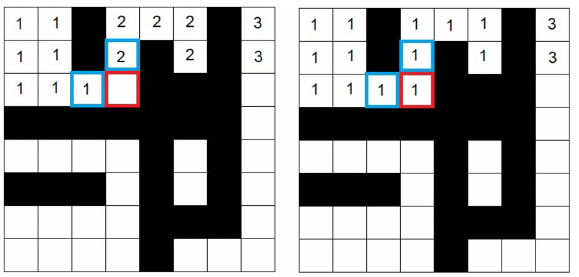
Figure 15. Example of shape extraction algorithm (on the left ) and example of combining labels of shape extraction algorithm (on the right